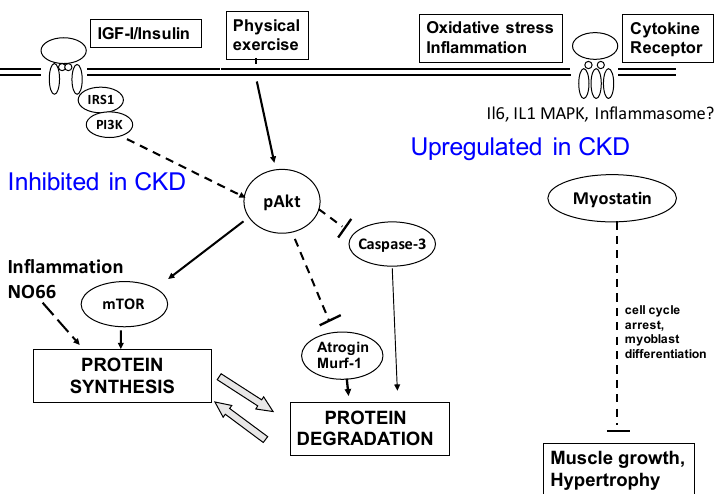
Figure 2. Scheme of mechanisms by which chronic kidney disease (CKD) impairs muscle protein metabolism. The inhibition of PI3-kinase/Akt pathway is associated with an inhibition of IGF-I and insulin actions on muscle protein synthesis and growth; in addition, downregulation of p-Akt increases protein degradation, by acting on atrogin-1, MuRF-1 and caspase-3. Overexpression of Myostatin by inflammation results in cachexia by increased protein degradation because of upregulation of atrogin-1 and MuRF-1. Inflammation upregulates nucleolar protein 66 (NO66), which suppresses both ribosomal DNA transcription and muscle protein synthesis via a demethylase mechanism.